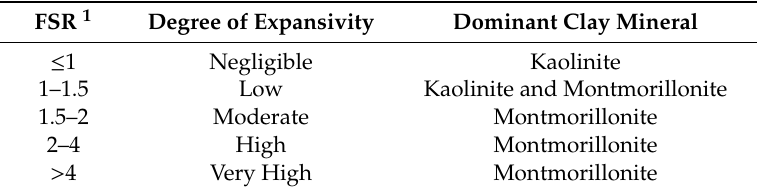
Table A1. Classification procedures for expansive soils based on the FSR [50].